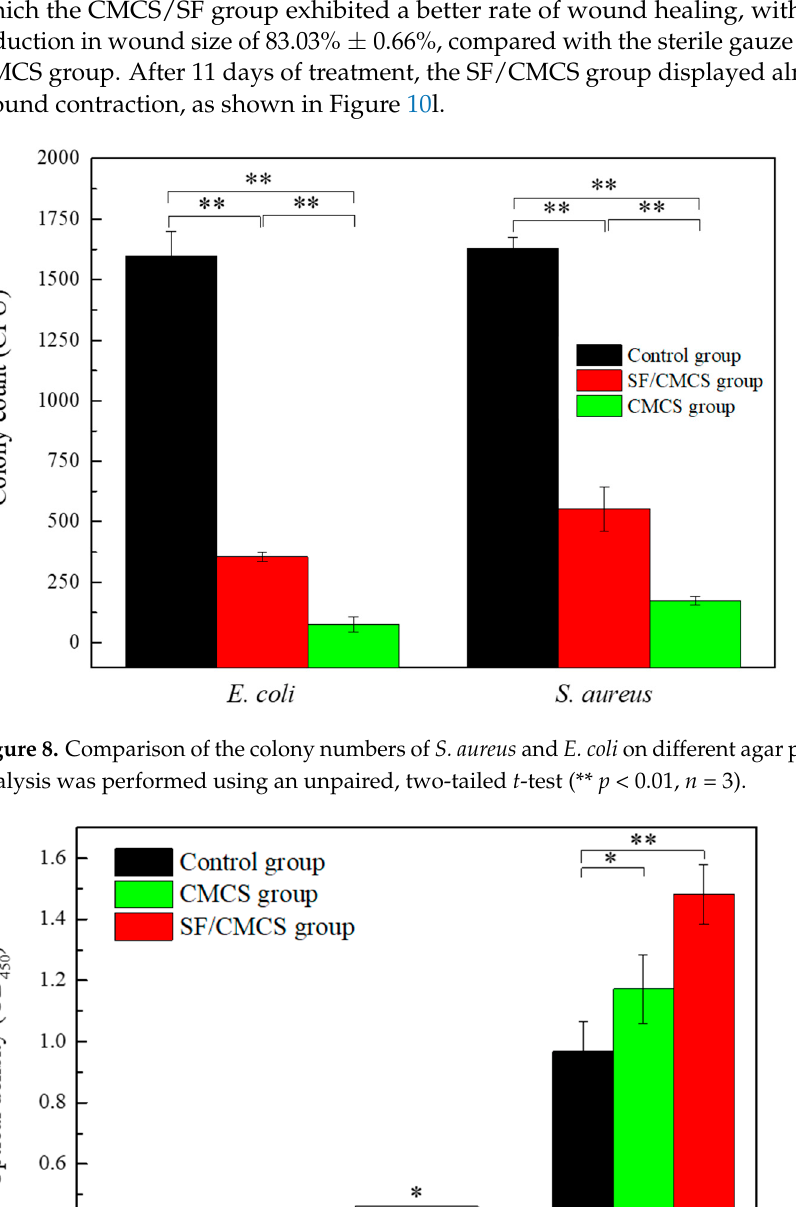
Figure 7. The degradation profiles of SF/CMCS and CMCS hydrogels.